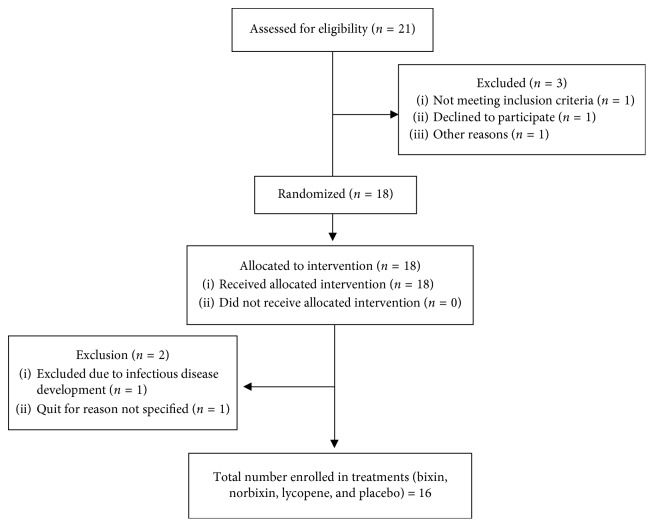
Consort flow diagram of recruitment, allocation, randomization, and retention of volunteers.